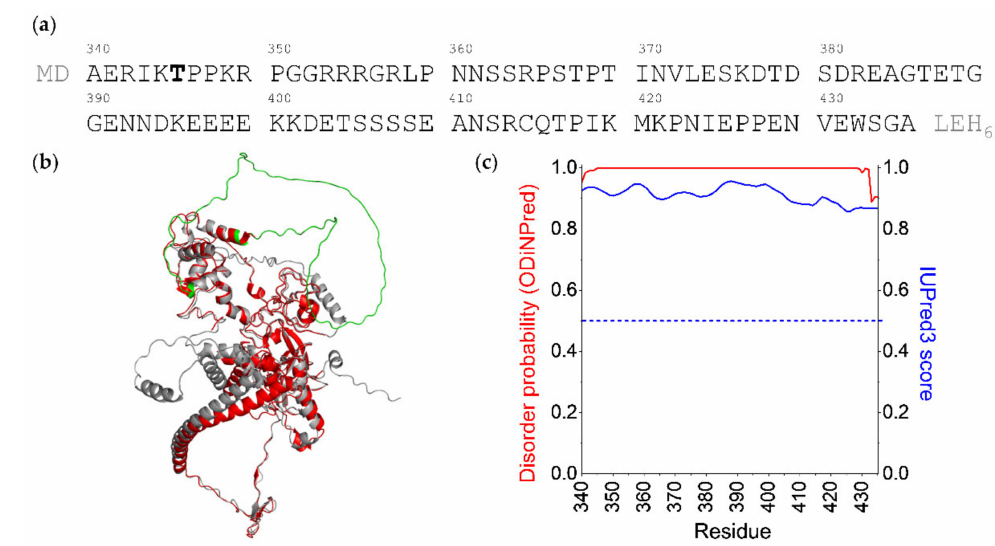
Figure 1. Characteristics of the studied EZH2 segment: ( a ) Amino acid sequence of the EZH2 loop region (UniProt Q15910), highlighting the mutation site Thr345; N-terminal MD and C-terminal LEH 6 residues are cloning artifacts. ( b ) Crystal structure (red) [6] of EZH2 superimposed with the AlphaFold predicted structure (gray). The studied loop region is highlighted with green. ( c ) Disorder probability predicted with ODiNPred [24] (red) and IUPred3 [23] scores (blue). The IUPred score indicates a disordered nature over